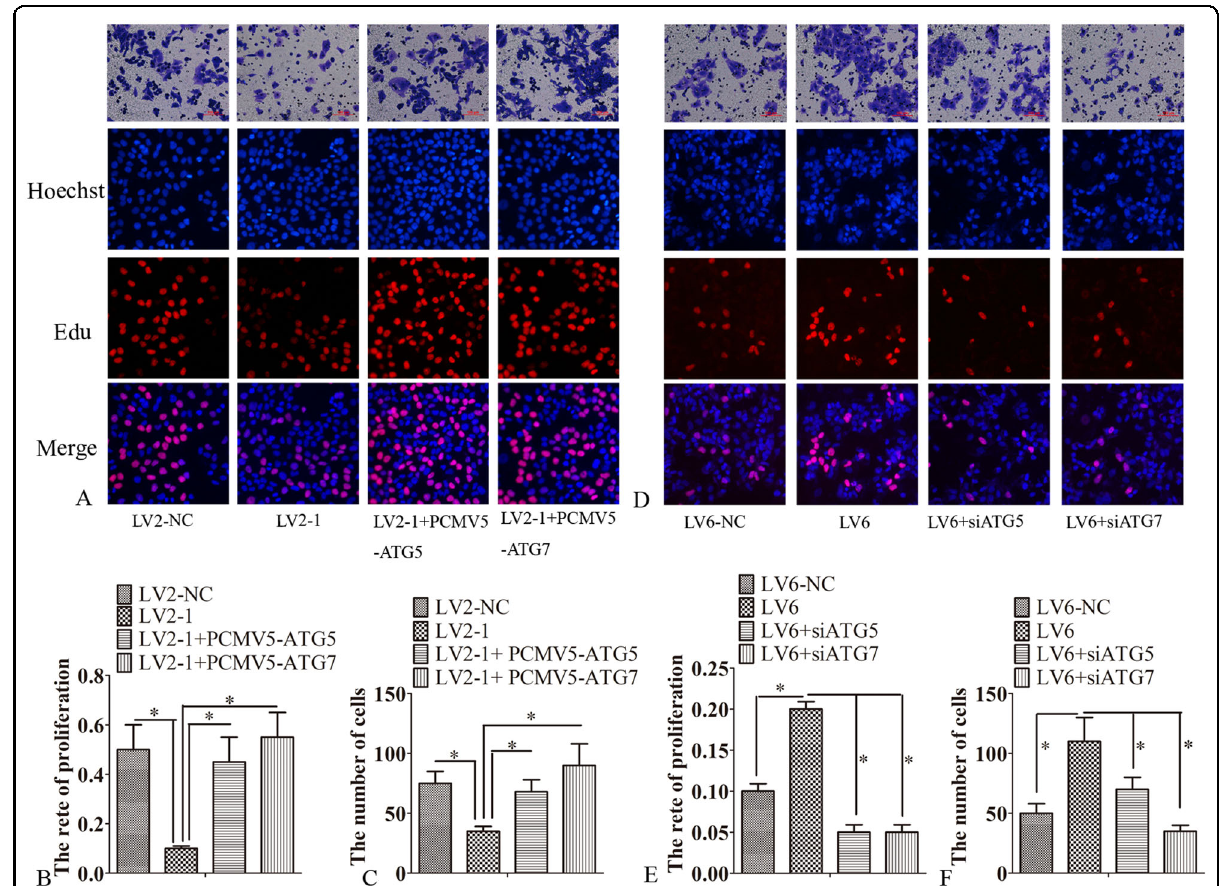
Fig. 3 CircRAB11FIP1-induced autophagy enhanced ovarian cancer cell growth and migration. A – C LV2-1, LV2-NC, LV2-1 + PCMV5-ATG7, or LV2-1 + PCMV5-ATG5 was transfected into SKOV3 cells. Cell proliferation and migration were examined 48 h later. D – F LV6, LV6-NC, LV6 + ATG7 siRNA, or LV6 + ATG5 siRNA was transfected into A2780 cells for 48 h. Then, cell proliferation and migration were examined. Error bar stands for standard error. * P < 0.05. Scale bar = 100